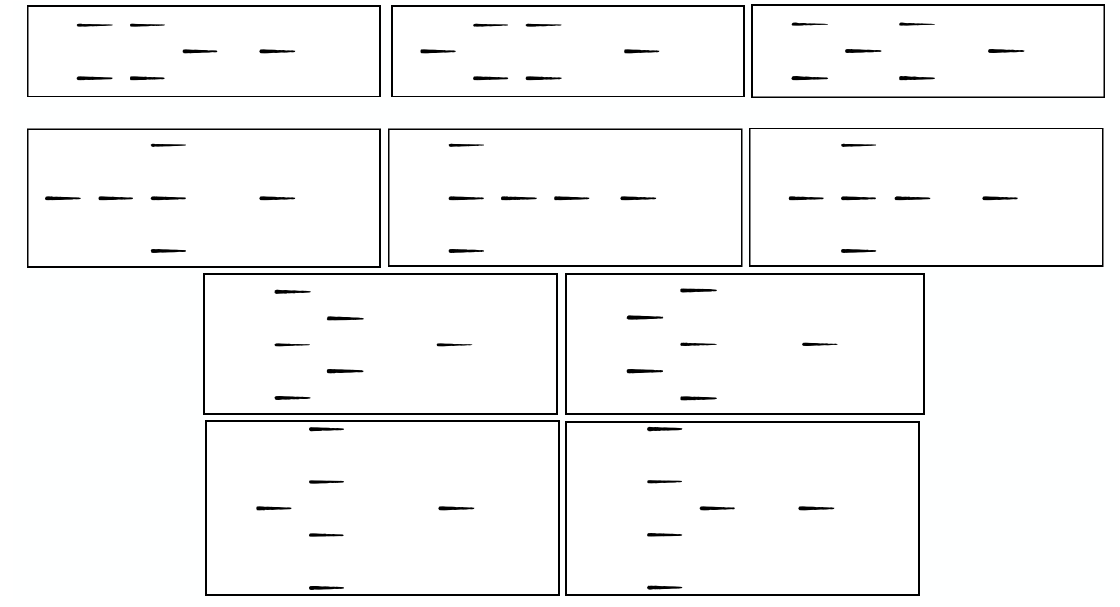
Figure A4. Configurations for five leading swimmers.